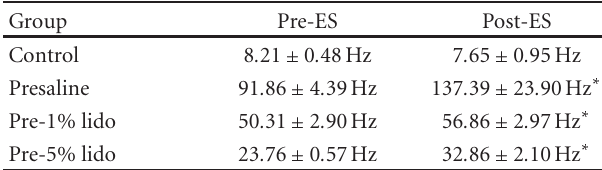
Table 1: Statistical comparison of mean values of the nerve discharges.